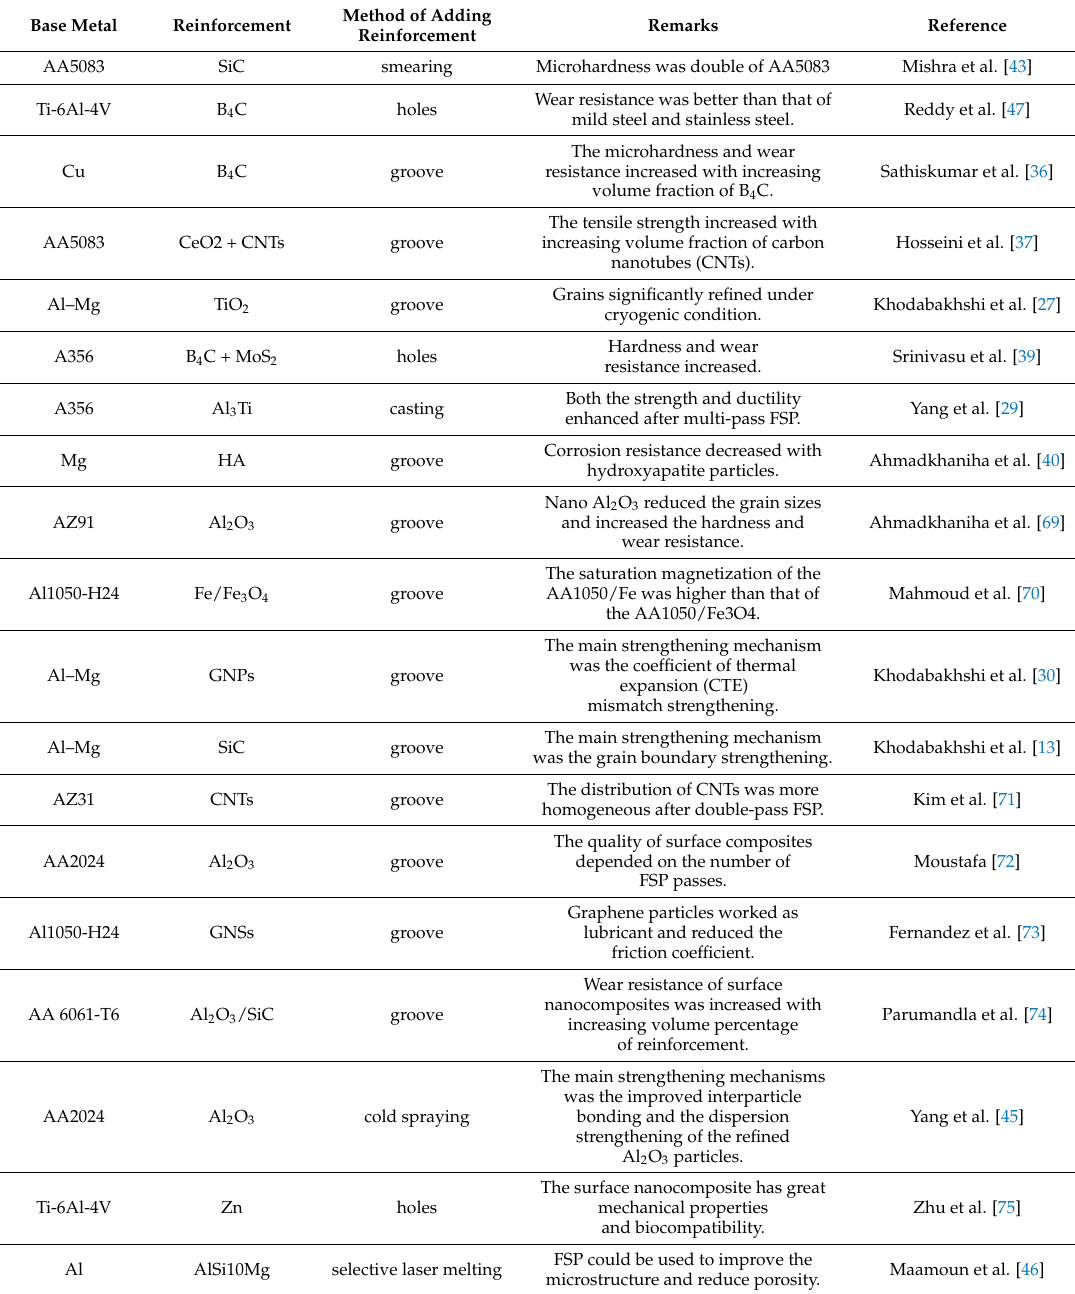
Table 2. Surface composites fabricated via